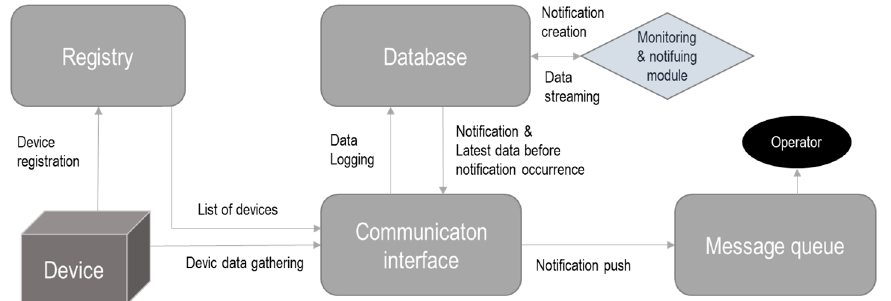
Figure 6. Self-monitoring approach, as proposed by ASSIST-IoT. Source: the authors’ own diagram, based on [73].